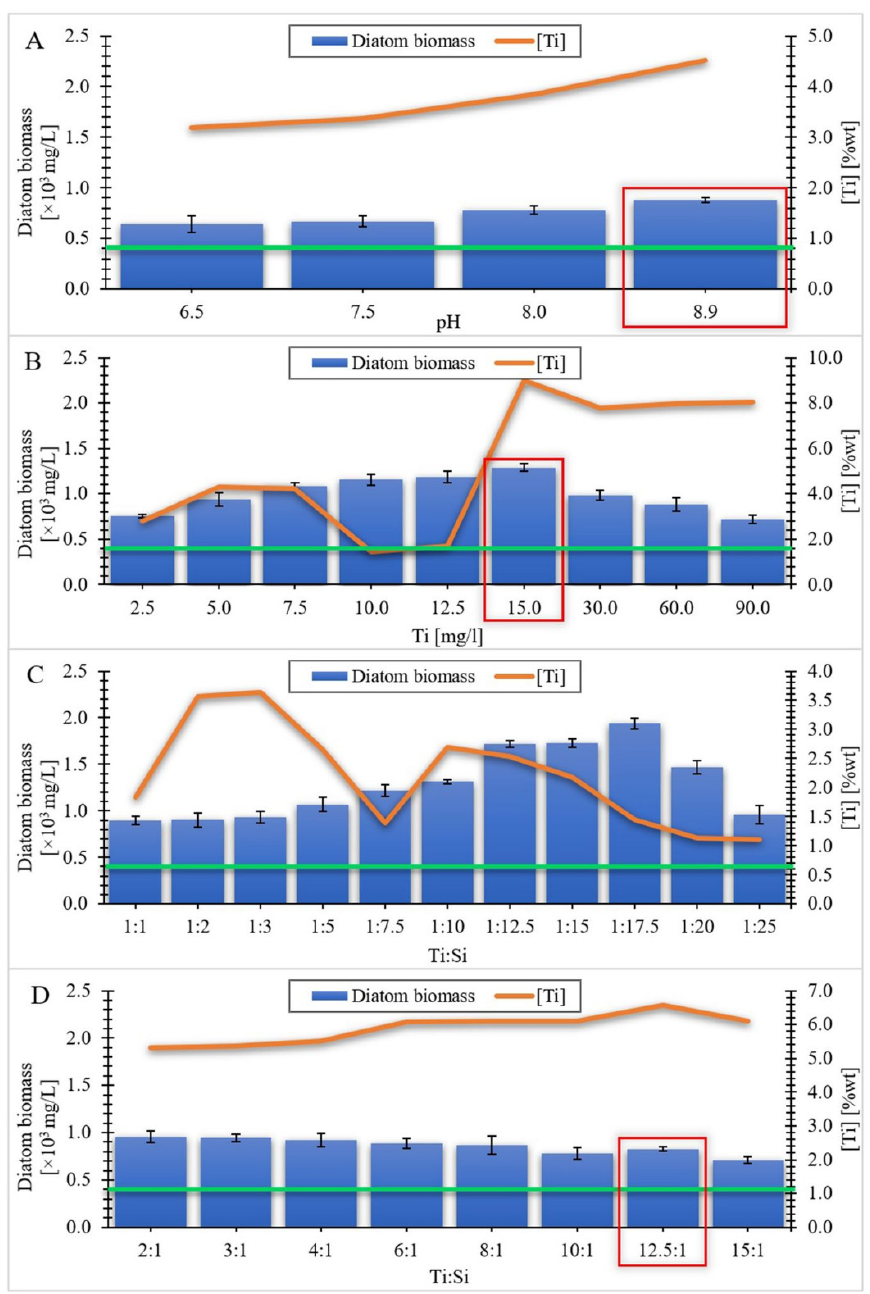
Figure 2. The amount of biomass per last day of culture as a function of ( A ) pH value; ( B ) Ti concentration; ( C , D ) Ti:Si ratio in relation to titanium content in diatom biomass in % weight (orange line). The undoped cell production value from the diatom species Pseudostaurosira trainorii is indicated by the green line. The red rectangle indicates the key samples for a given series of experiments.